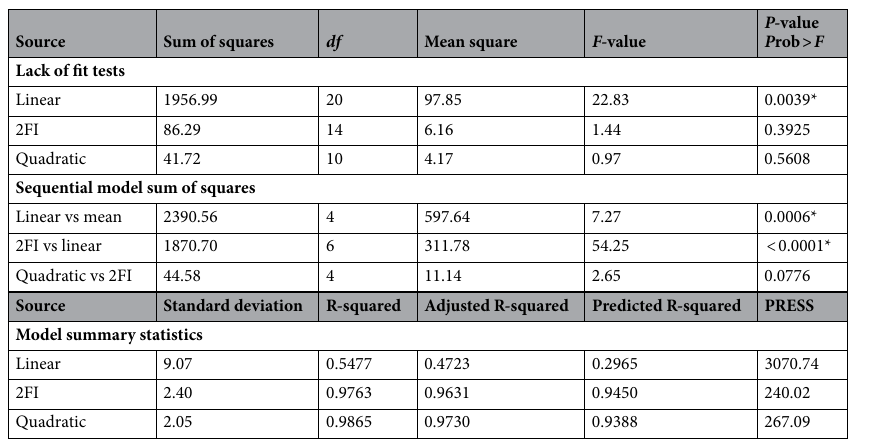
Table 3. Fit summary for Box–Behnken design results for biosorption of methyl orange dye by using Fucus vesiculosus. * Significant values, df degree of freedom, PRESS sum of squares of prediction error, 2FI two factors